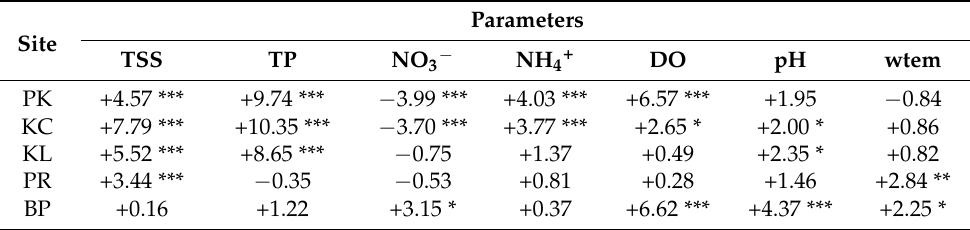
Table 2. Seasonal Mann-Kendall analysis on monthly water quality parameter time